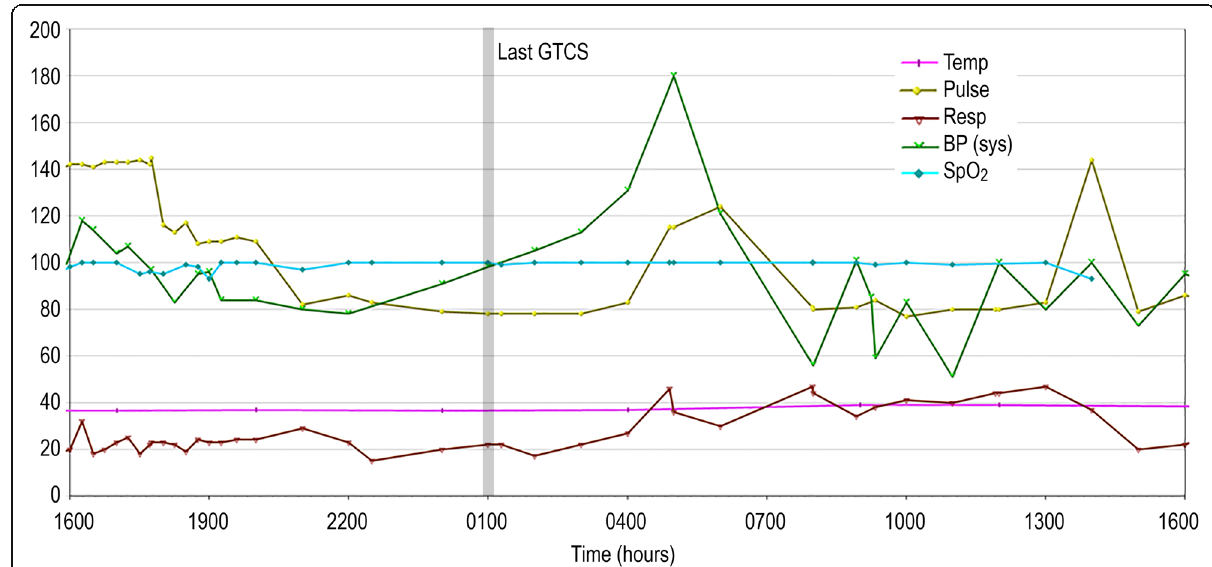
Fig. 3 Temporal illustration of periictal vital signs including heart rate, blood pressure, and body temperature and oxygen saturation over the course of 24 h. The possible terminal GTCS and PGES occurred at the time of 1:00 and brain death occurred at the time of